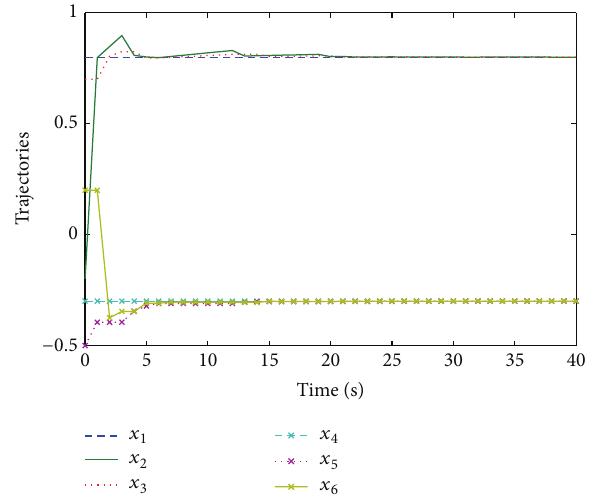
Figure 2: State trajectories for continuous-time case.